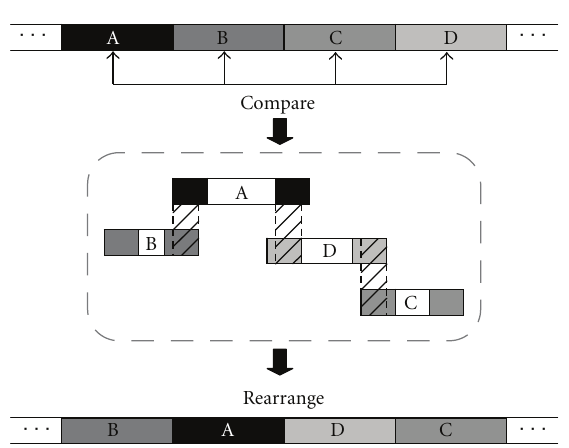
Figure 6: Chromosome Refinement (CRef)